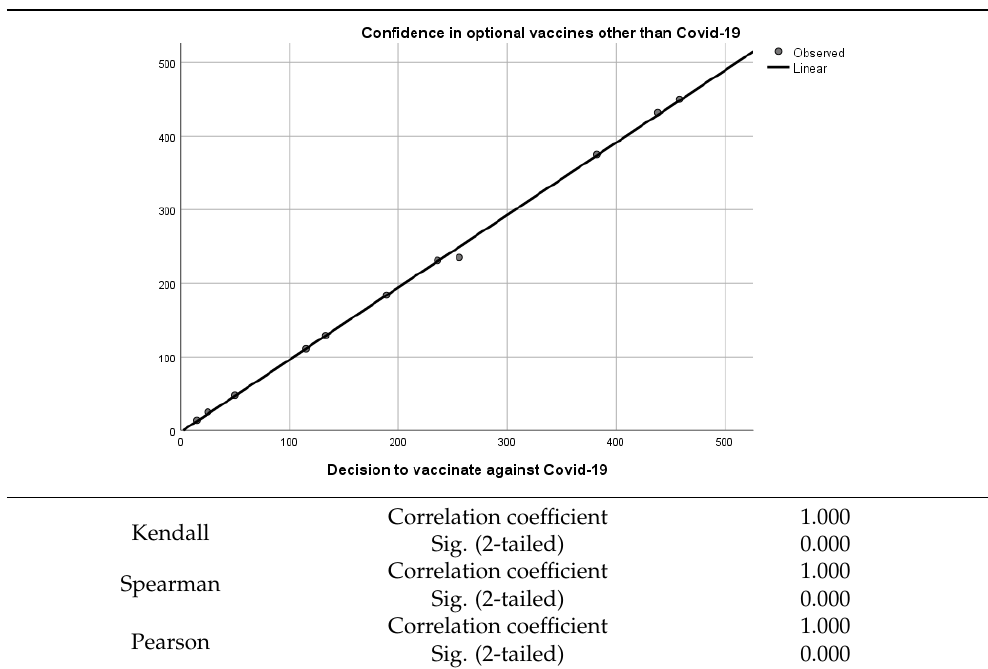
Table 9. Correlation between the variable “confidence in optional vaccines” and participants’ decision to vaccinate against COVID-19.